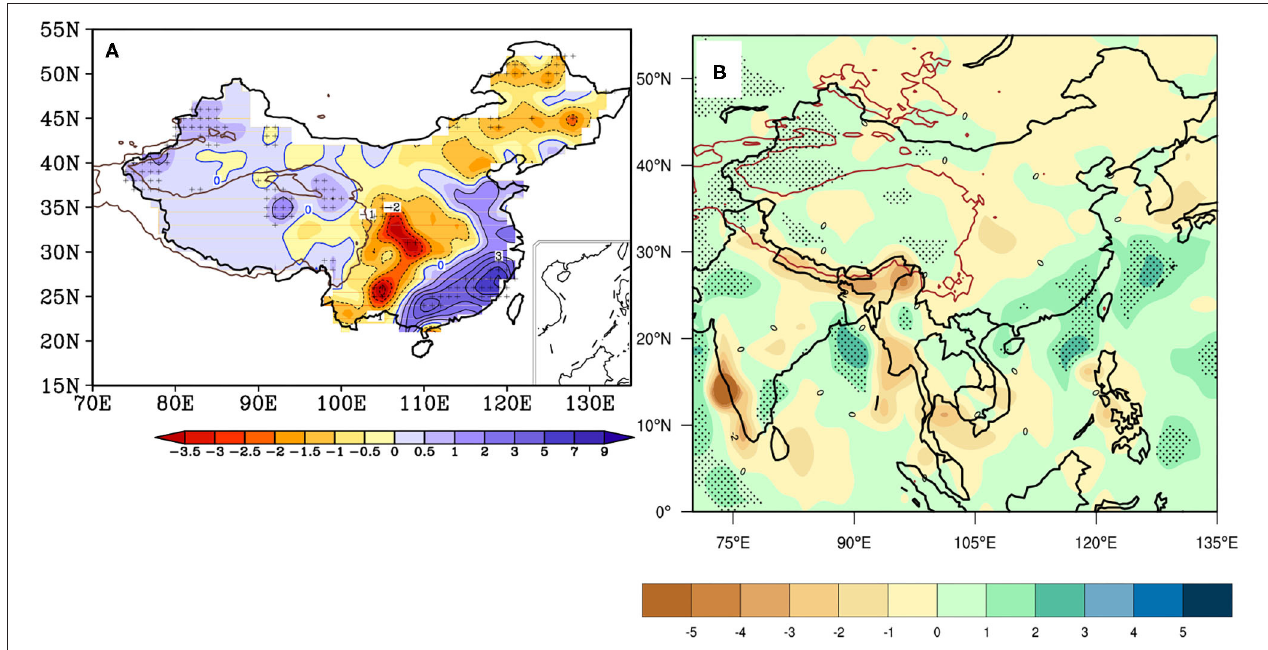
FIGURE 4 | Spatial distribution of precipitation trends in (A) China (based on observations) and (B) East Asia (based on GPCP data; brown contour delineates an altitude of 2,000m) in the summers of 1980–2016 (units: mm/decade; cross symbols indicate statistical significance above the 95% confidence